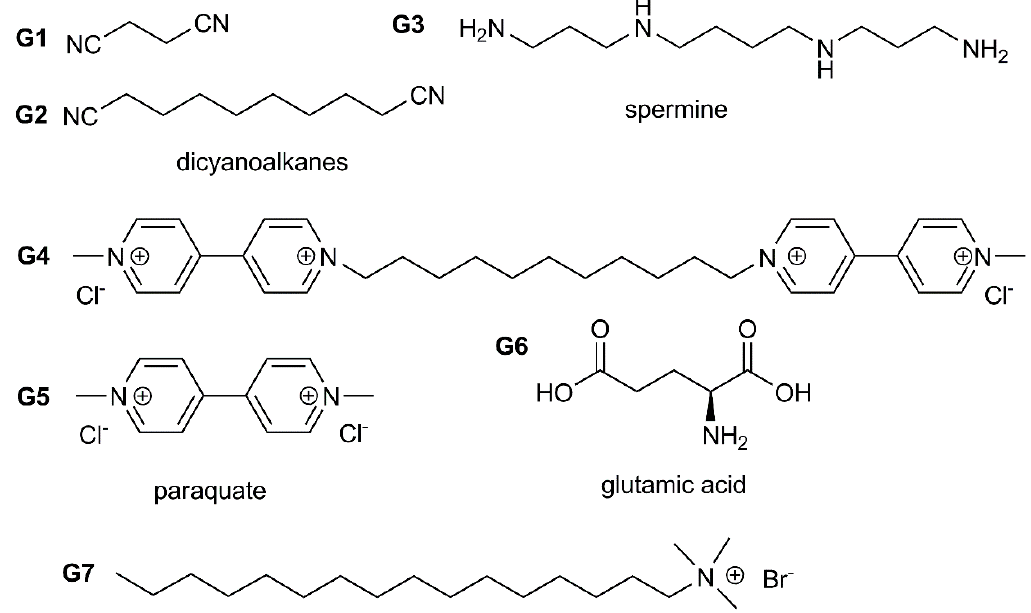
Figure 9. Structures of guest molecules for recognition using pillar[n]arene-based AgNPs.